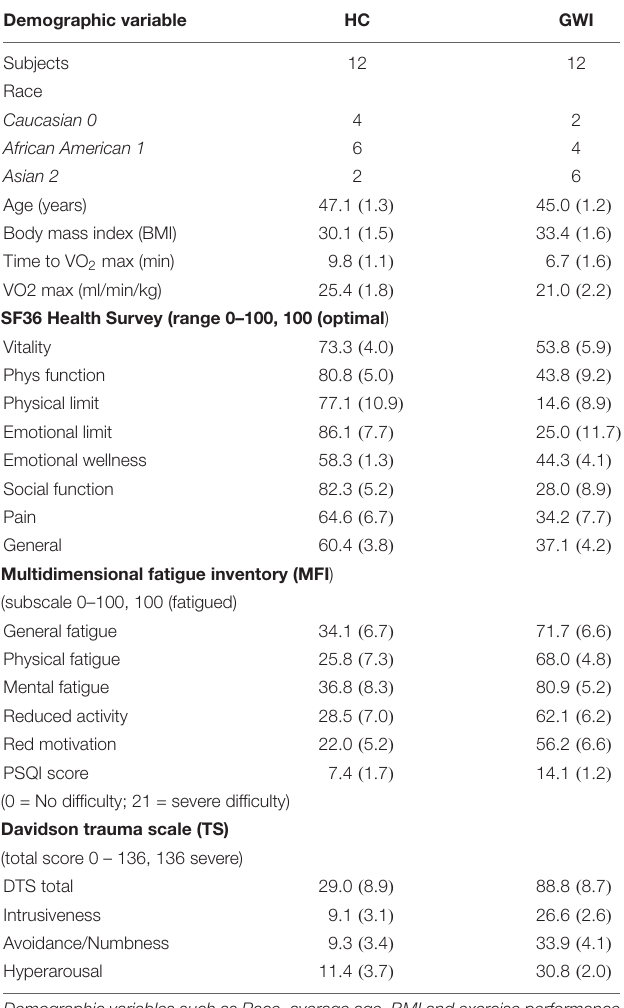
TABLE 1 | Summary of demographic variables and exercise